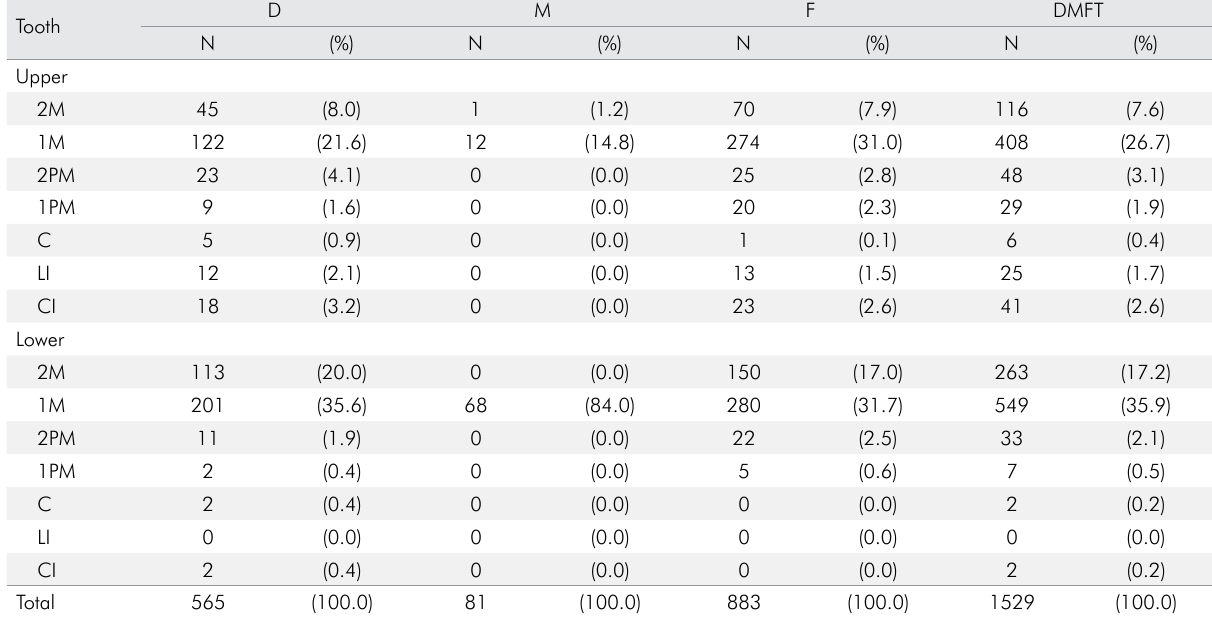
Table 3. Distribution of decayed (D), missing (M), and filled (F) components of DMFT index according to tooth group in male adolescents from southern